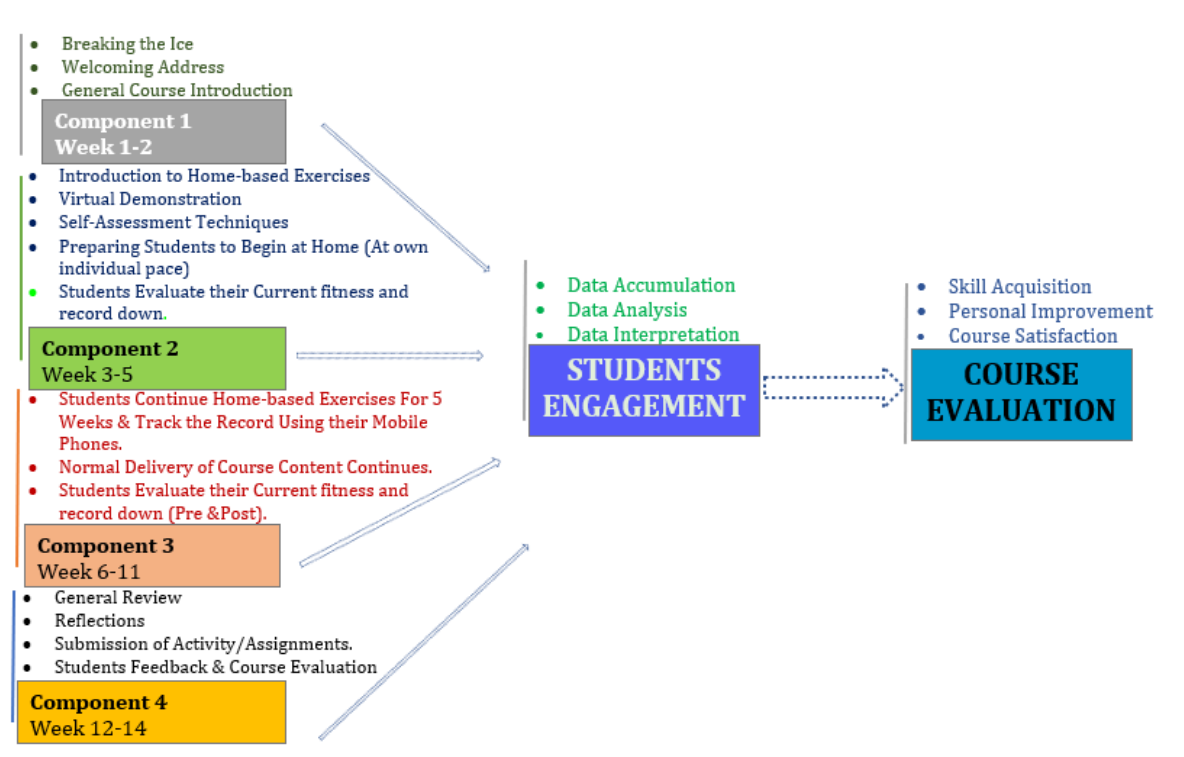
Figure 2. Methodological flowchart of the course design.